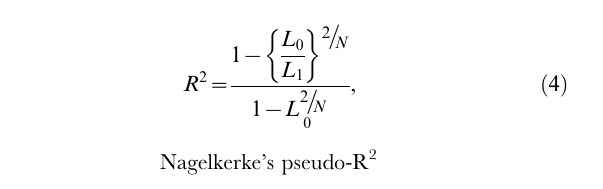
Figure S3 DRB1*15:01-stratified analysis for the SNPs tagging the non-classical HLA LD haplotype. The y-axis lists the SNPs in positional order. The x-axis displays the respective Odds Ratios and 95% confidence intervals of these SNPs while analyzing with a univariate model: a) all individuals [cases: 5,091; controls: 9,595] (black color), b) DRB1*15:01 carriers [cases: 2,794;